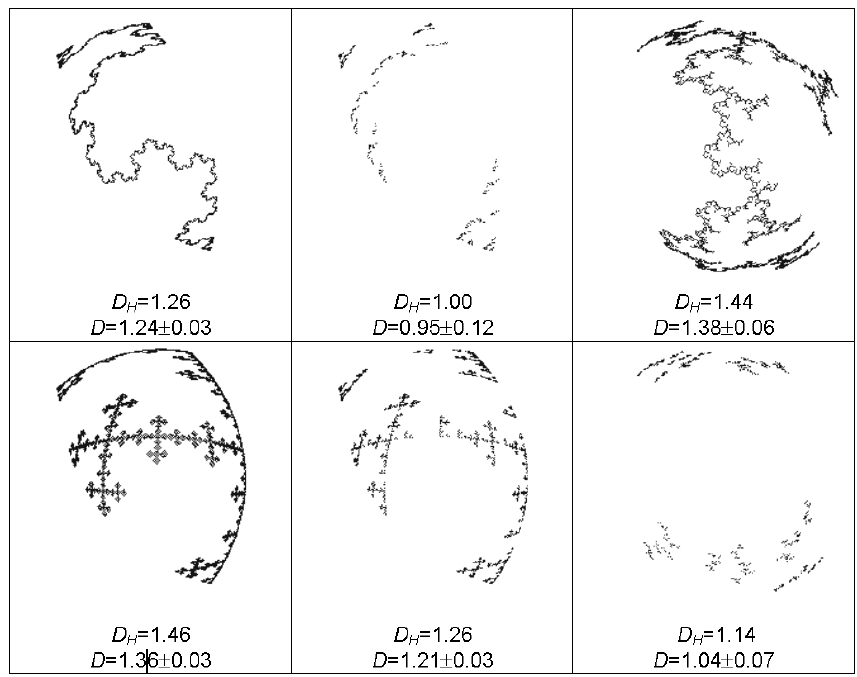
Fig. 5. Examples of the regular prefractal structures, transformed by all-sky projection: D H – theoretical fractal dimension; D – box-counting dimension calculated by the image.